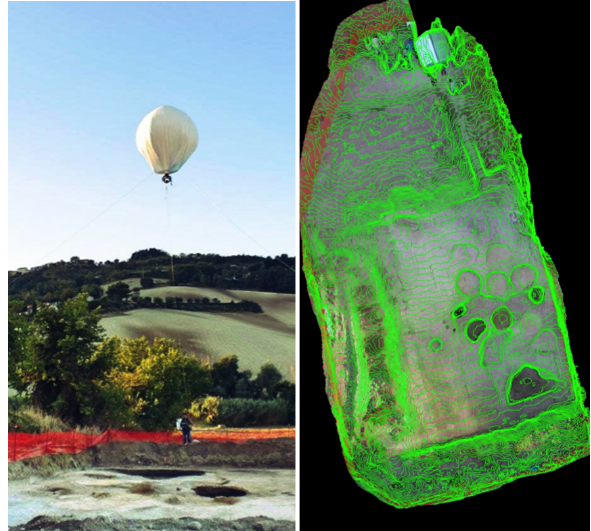
lowing georeferenced orthoimage with contours line on the top (excavation campaign